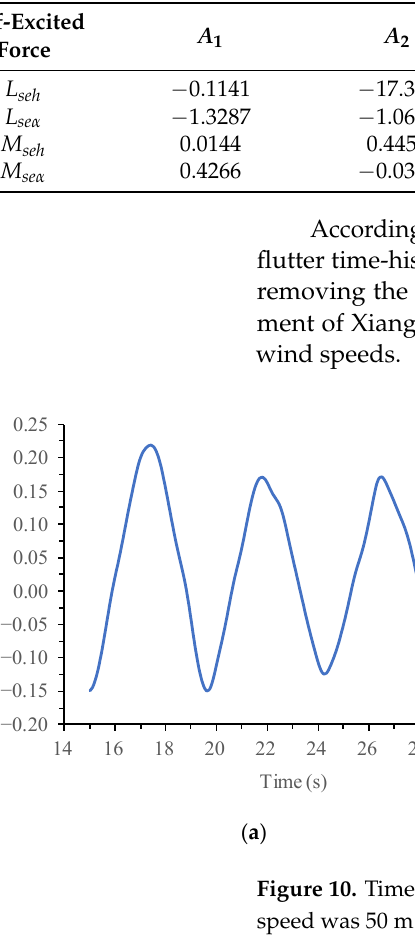
Table 4. Time-domain fitting of flutter derivatives of Xiangshan Harbor Bridge. Table 4. Time ‐ domain fitting of flutter derivatives of Xiangshan Harbor Bridge.